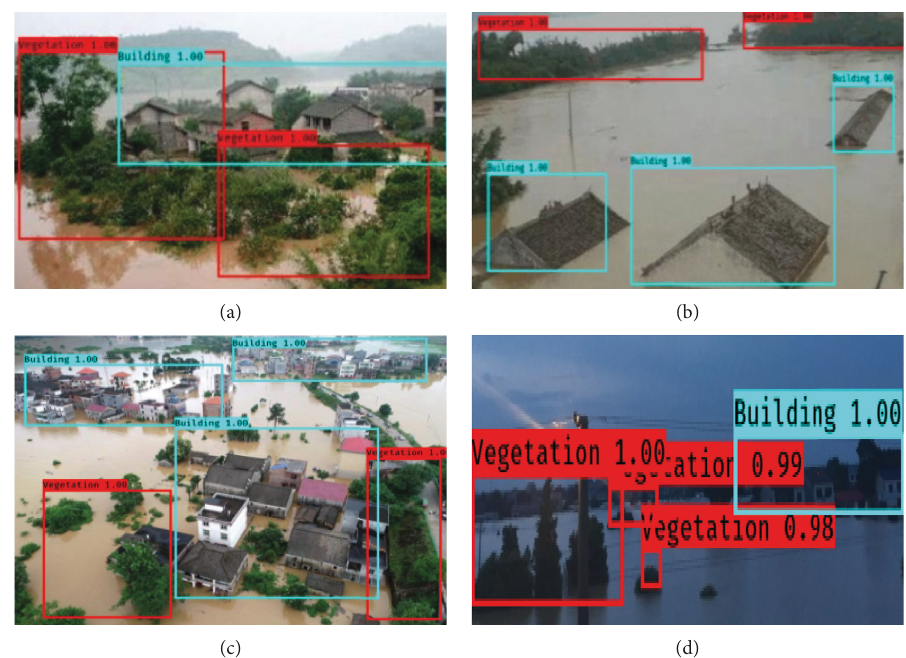
Figure 11: Examples of the recognition effect. (a) Good quality and illumination condition. (b) Image under insufficient light. (c) Image under occlusion. (d) Only the building roof is